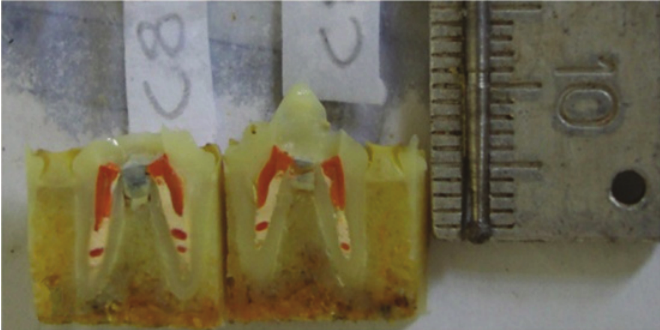
FIGURE 1 – A maxillary second premolar cut along the proxi-proximal direction and placed beside a H1016 bur and a ruler for scale. The length of the perforations was defined by the cusp apex and the groove in the burr shank. Note the cement in the dental portion of the perforation.